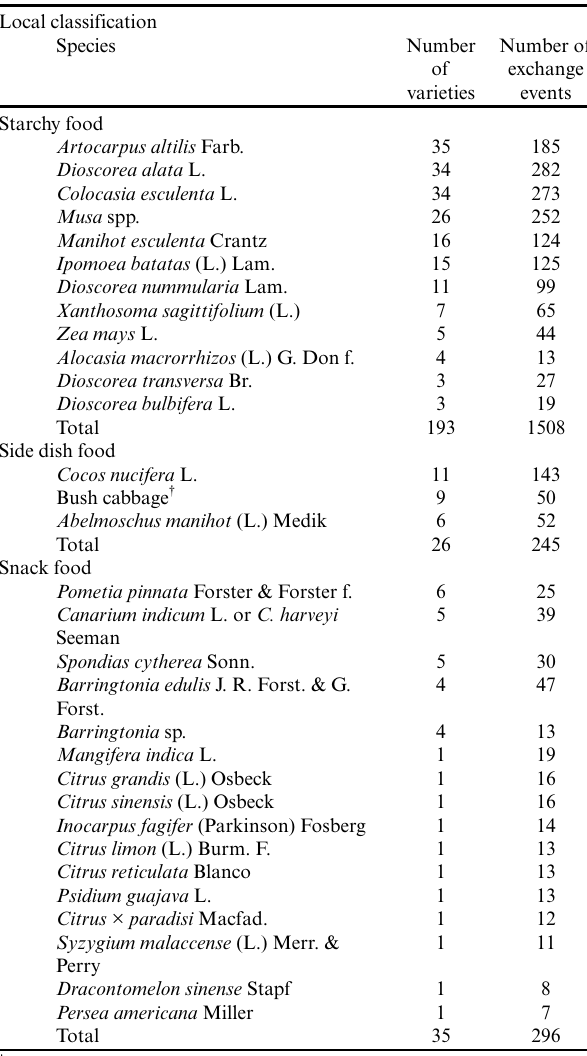
Number of of exchange varieties